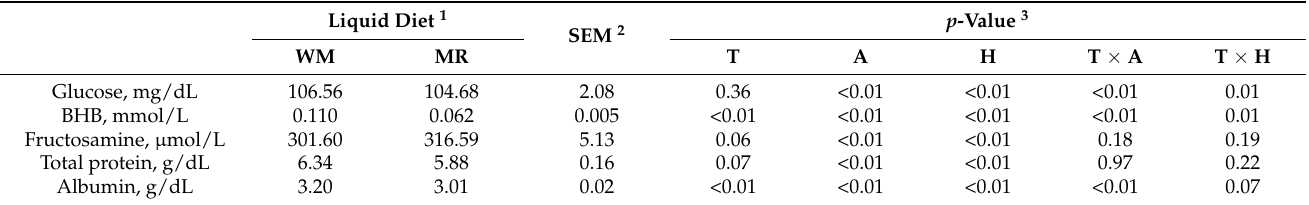
Table 3. Blood metabolites of dairy calves fed whole milk (WM) or milk replacer